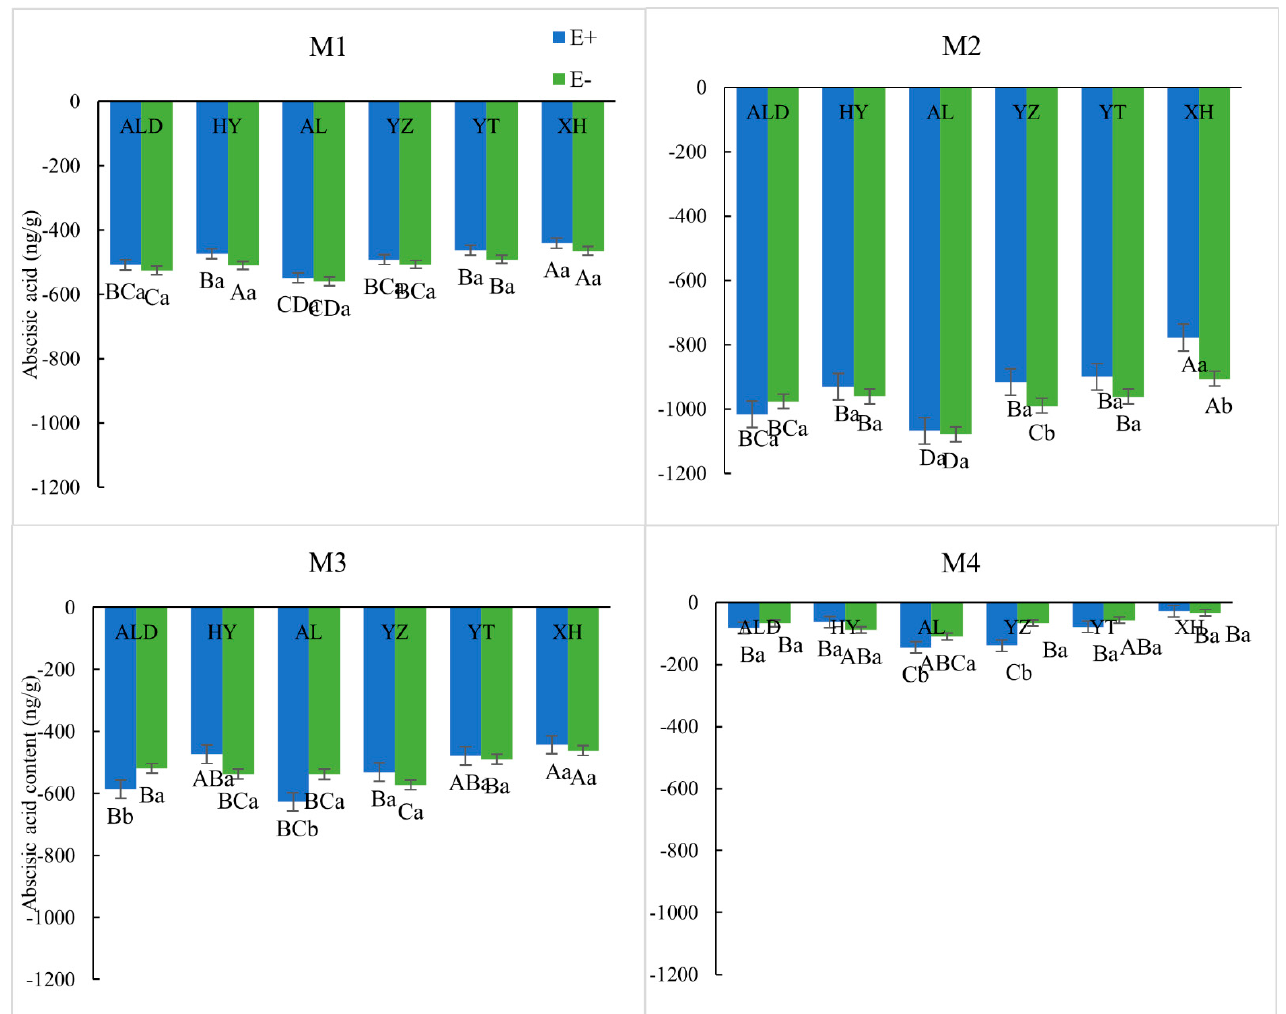
Figure 4. Abscisic acid content of infected (E+) and noninfected (E − ) Achnatherum inebrians from different methods on an altitude (origin) gradient. Different capital letters indicate mean significant difference ( p < 0.05) in endophyte status (E+ or E − ) in seed germination under different origin. Different lowercase letters indicate mean significant difference ( p < 0.05) in pair-wise comparisons of endophyte status (E+ and E − ) in seed germination in same origin. Table 3. Effects of origin, endophyte, dormancy-breaking method, and their interaction on germination and content of soluble sugar, gibberellin, auxin, and abscisic acid in seeds of Achnatherum inebrians . Df = degree of freedom, F = f value is ratio of two means to effect/error term, p =